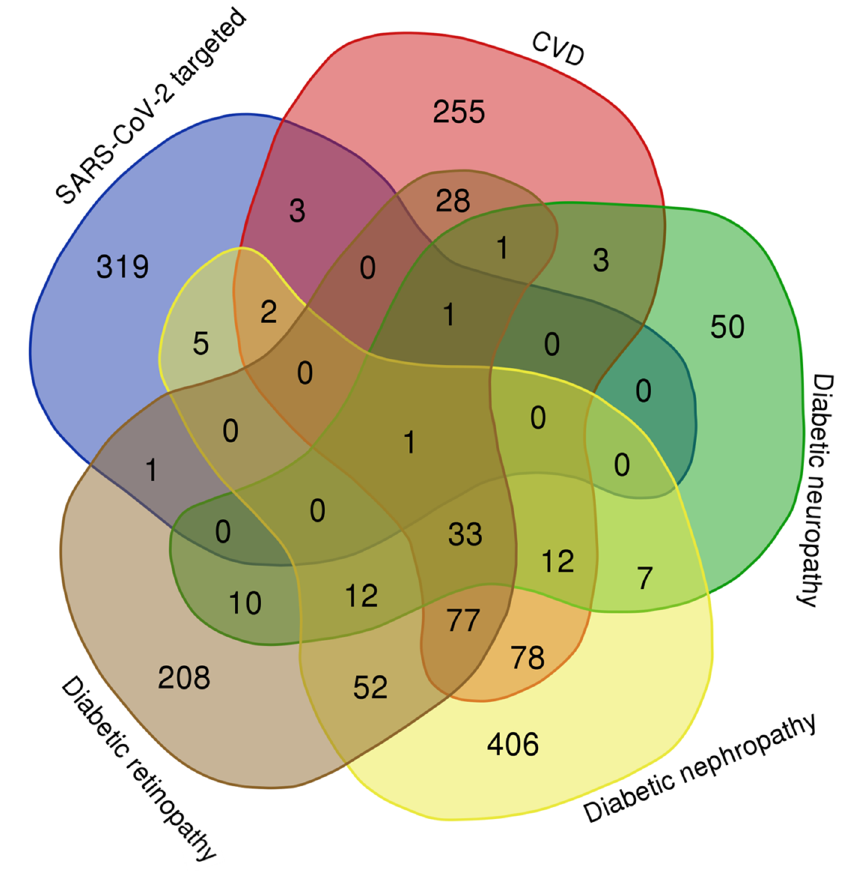
Figure 12. Venn diagram of intersection of the lists of SARS-CoV-2-targeted proteins and gene/protein sets associated with cardiovascular disease, diabetic neuropathy, diabetic nephropathy, and diabetic retinopathy. Numbers show the gene/protein count.